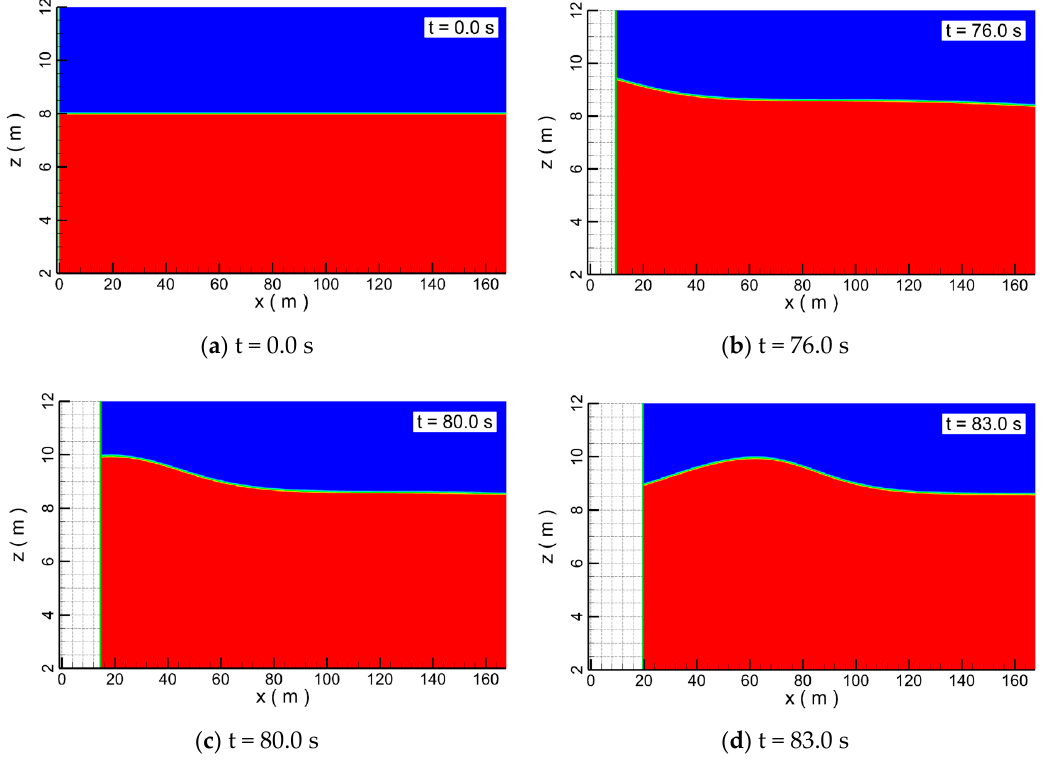
Figure 11. The wave generation process around the wave paddle.